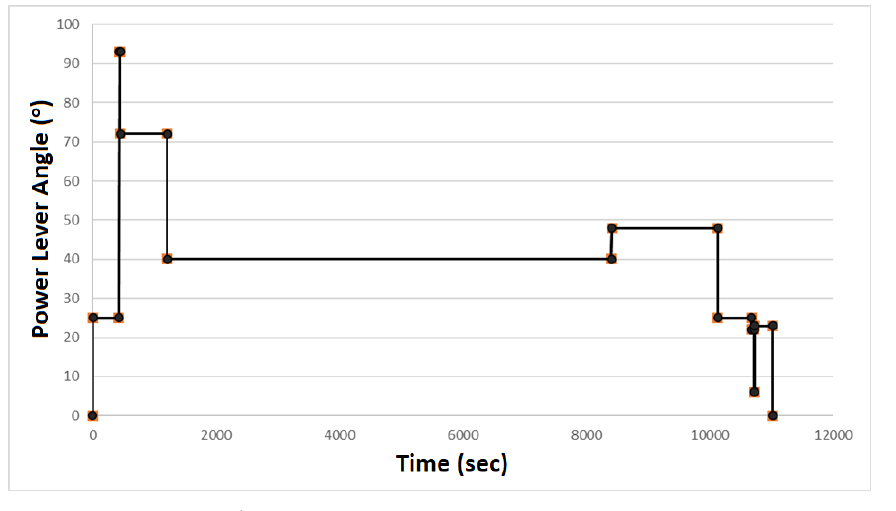
Figure 4. PLA History for EMB-135.